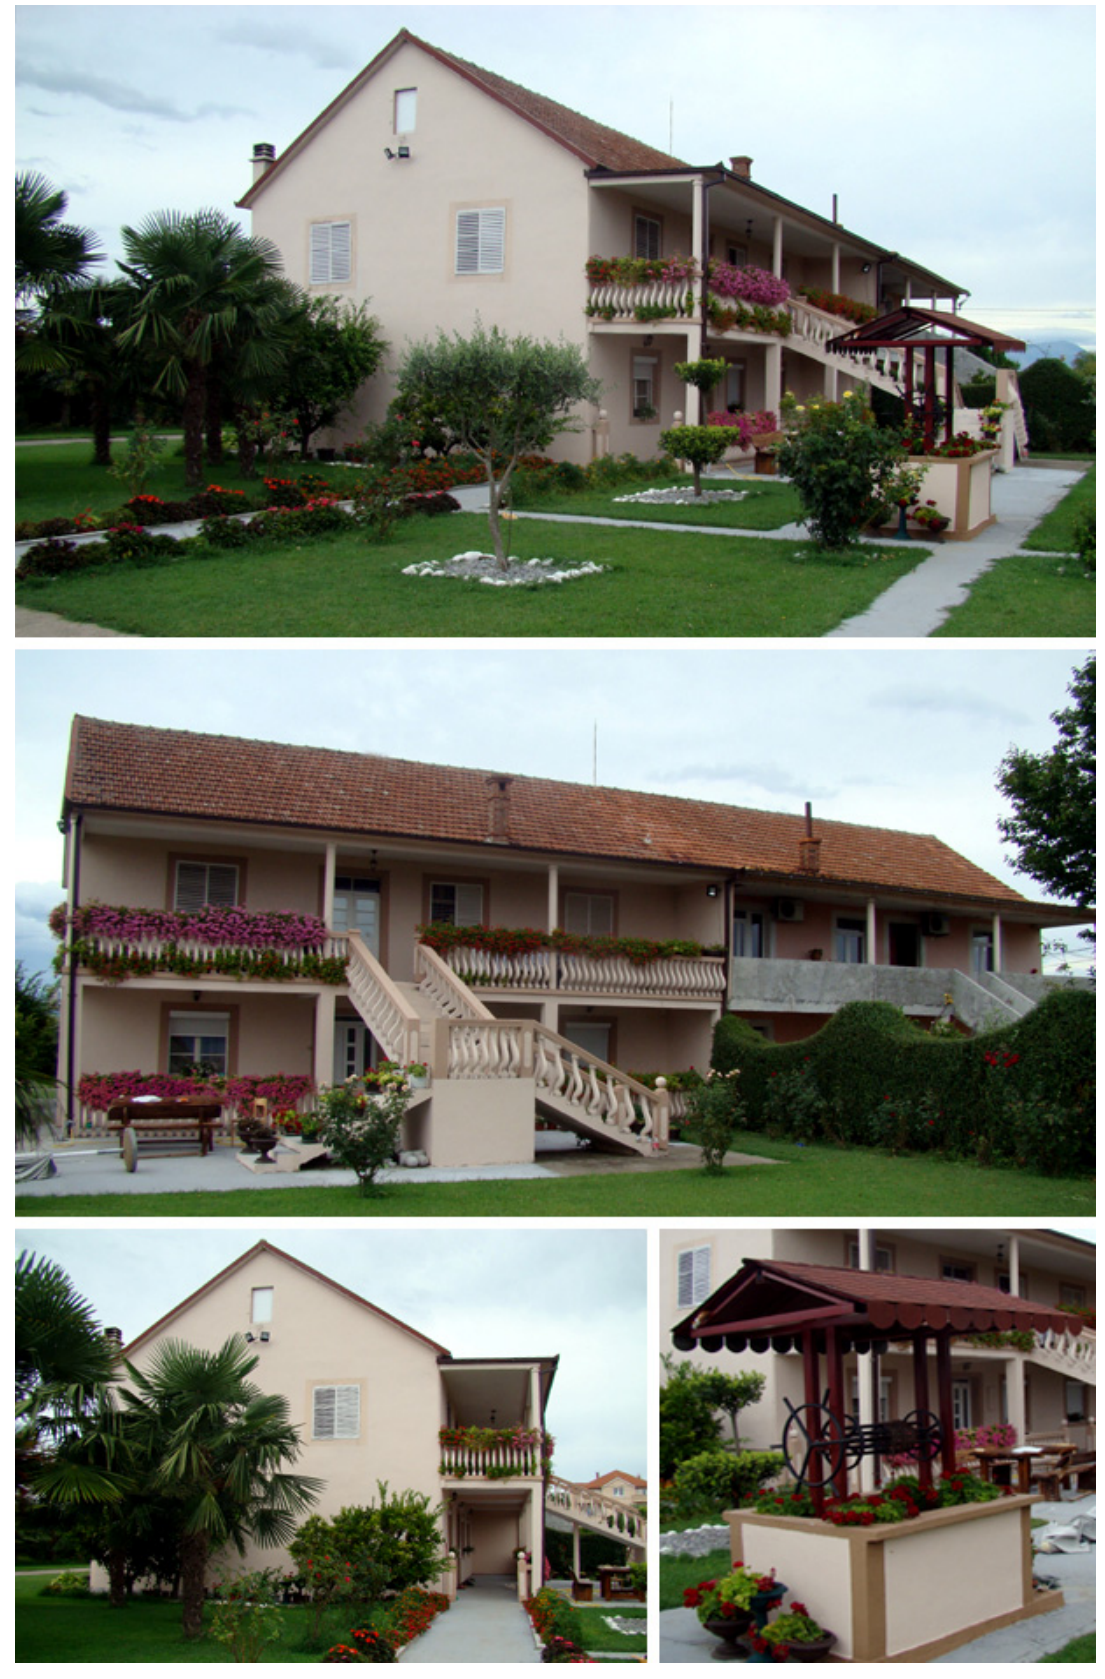
Figure 12. Photos of the House of Skataric, Zeta region, Montenegro (Photo G. Skataric).